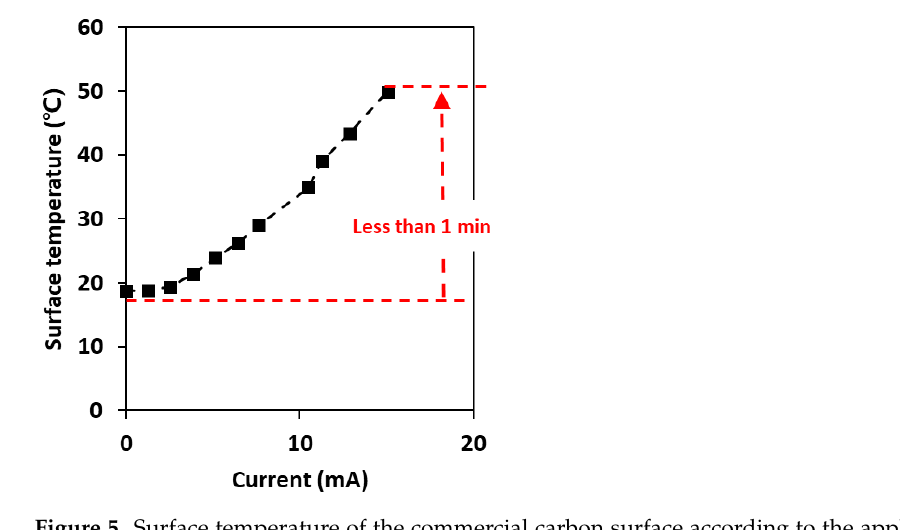
Figure 5. Surface temperature of the commercial carbon surface according to the applied current under AC